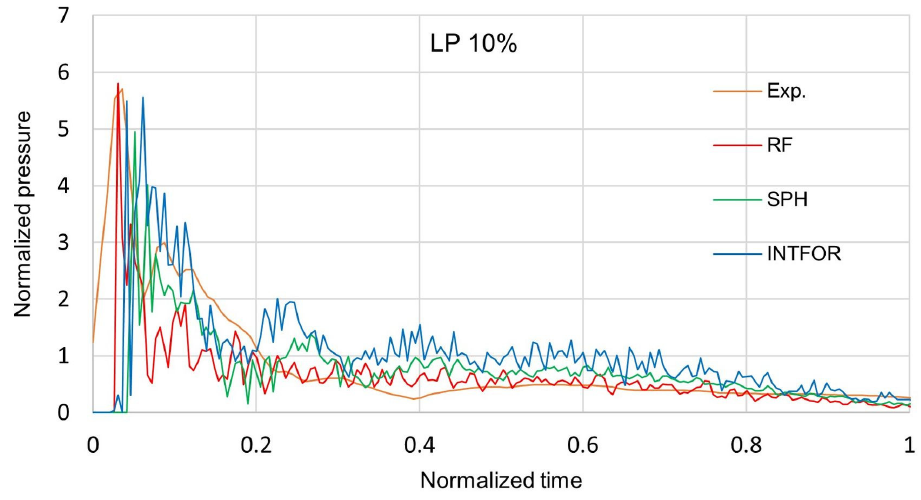
Figure 28. Profiles of normalized pressure for experimental and numerical analyses.